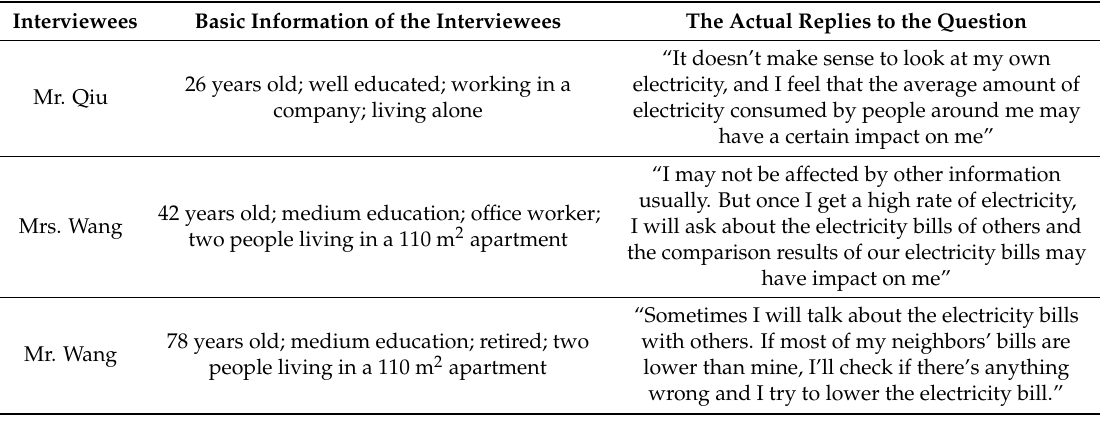
Table 1. A summary of partial interview relevant to “What kind of feedback information will have remarkable impacts on customers?” and the basic information of the corresponding